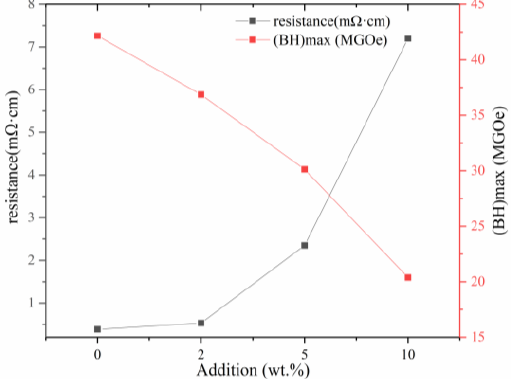
Figure 5. Electrical resistivity and magnetic energy products of the hot-deformed ones in confirmatory experiment samples with different additions.